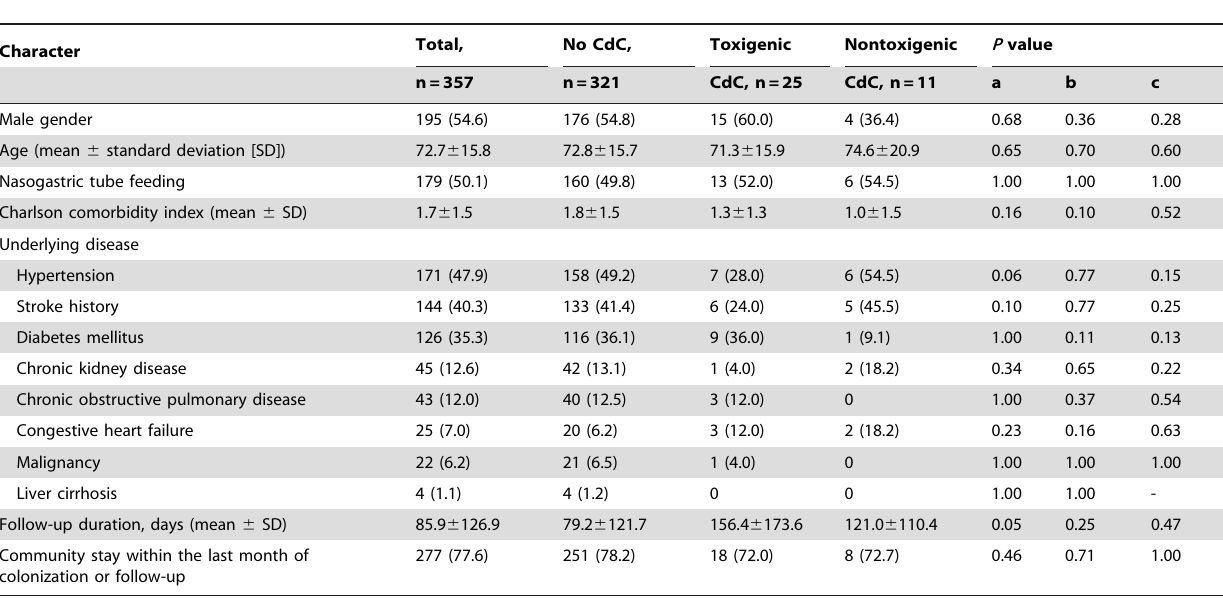
Table 1. Comparisons of 357 patients without fecal Clostridium difficile colonization (CdC) at admission, stratified by the presence or absence of toxigenic or nontoxigenic CdC in the feces during